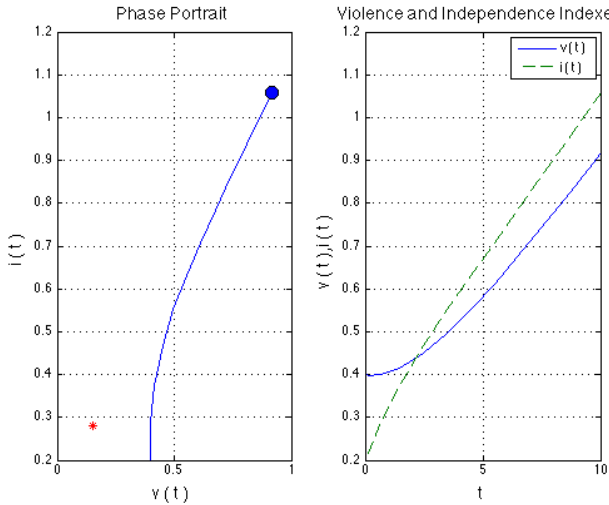
Figure 3. Violent man without alcohol consumption, empowerment woman. α 1 = 0.5, α 2 = 0.6, β 1 = 0.3, β 2 = 0.3, γ = 0.6, δ 1 = 0.25, δ 2 = 0.25, ρ 1 = 0.5, ρ 2 = 0.5, µ = 0.6, ( v ( 0 ) , i ( 0 )) = ( 0.4,0.2 )